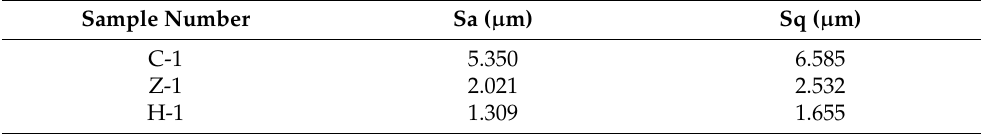
Table 2. Surface unevenness parameters of pearl samples with different